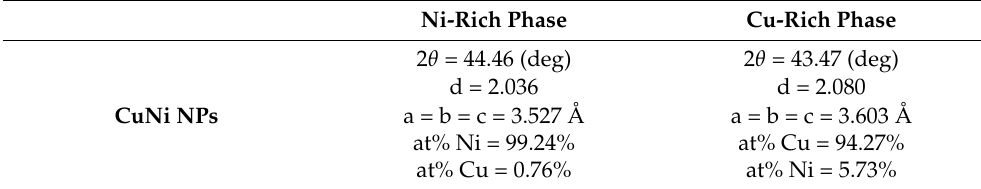
Table 2. Composition of the Ni-rich and Cu-rich phases present in the CuNi NPs and chitosan free- standing film, as determined from XRD analyses. Ni-Rich Phase